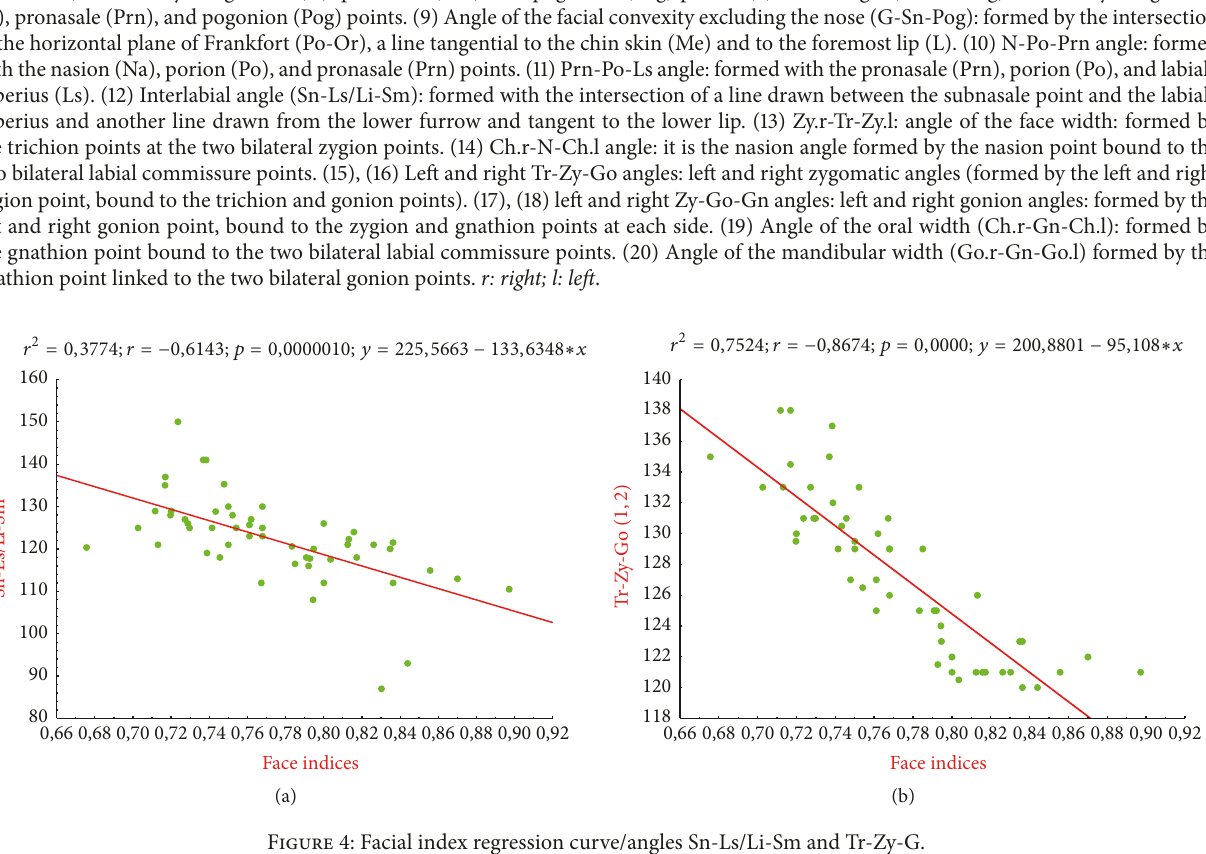
Figure 4: Facial index regression curve/angles Sn-Ls/Li-Sm and